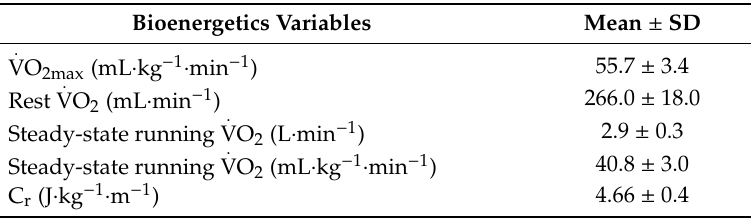
Table 2. Bioenergetics variables.